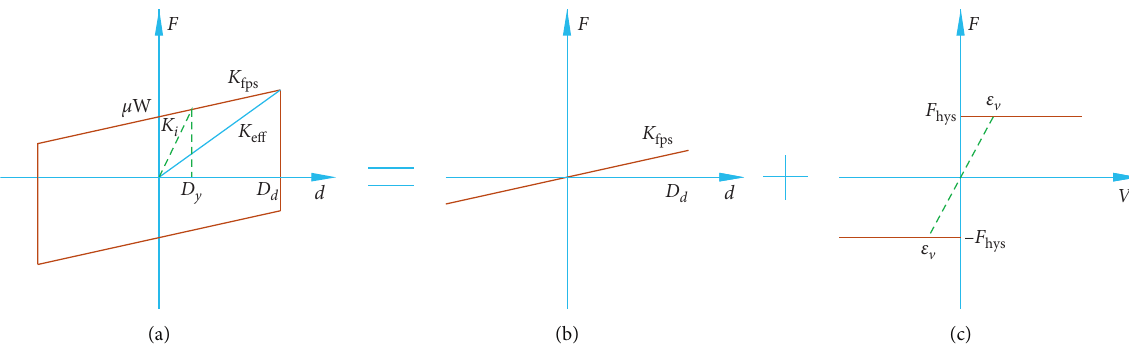
Figure 5: Load-displacement hysteresis curve of